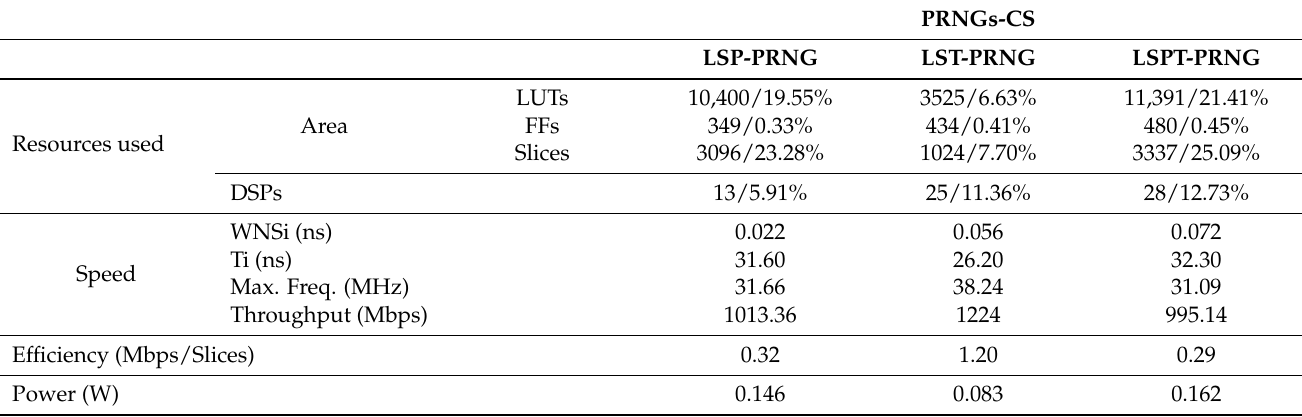
Table 7. Harware metrics comparison of the proposed PRNGs-CS using ZYNQ PYNQ-Z2